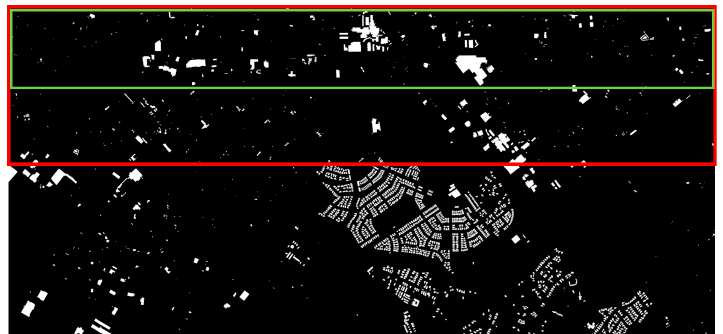
Figure 10. The change map of the study area (TA-2011 and TA-2016) with 2007 changed buildings. The red box contains training samples, and the rest are test samples including 1715 changed buildings. The green box expresses only half of the samples used for training.